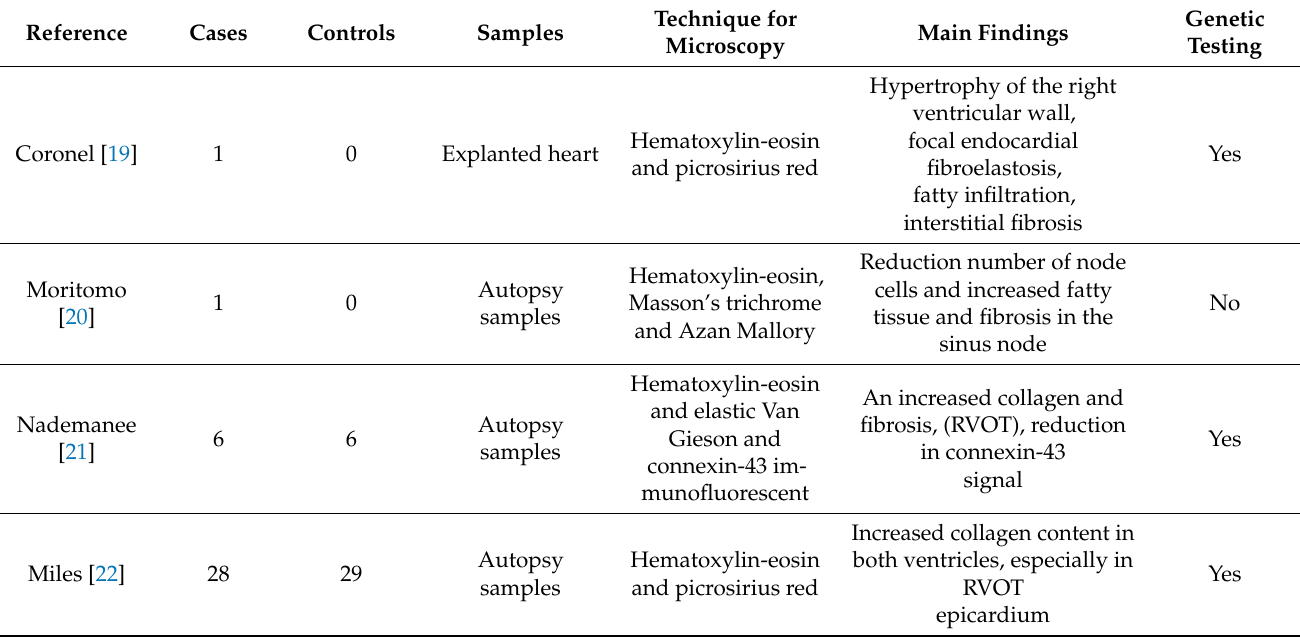
Table 1. Summary of the literature review regarding explanted hearts/autopsy